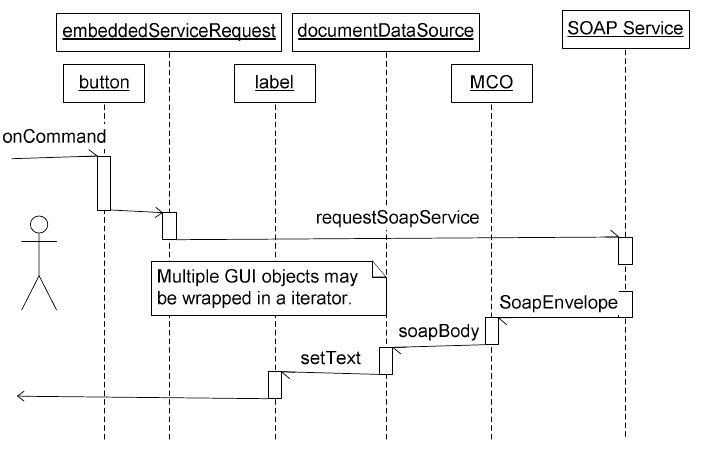
Figure 4. Communication through XAP Rich Client.